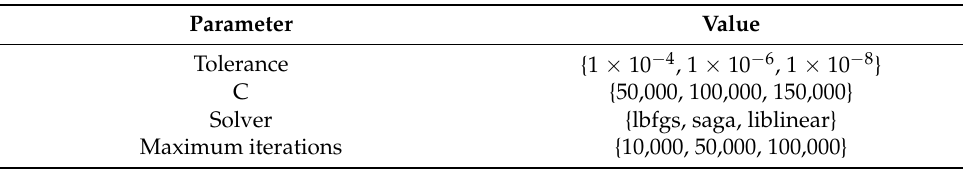
Table 4. Hyperparameters values for the tuning process of LoGit.